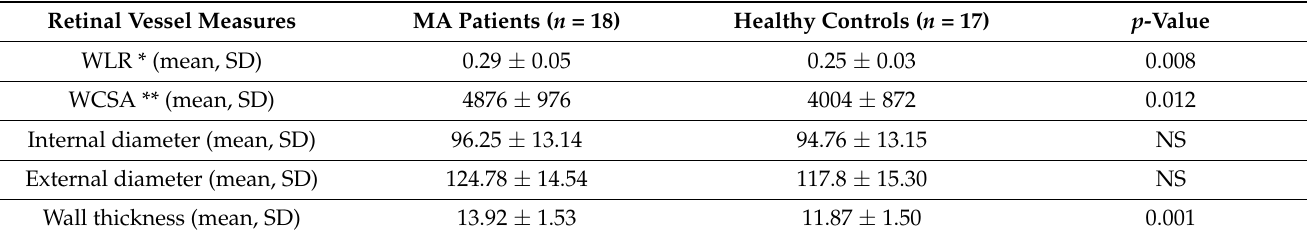
Table 1. Retinal arteriole wall thickness, WLR, and wall cross-sectional area in patients with MA as compared with controls. Mean differences are adjusted for BMI (see text for